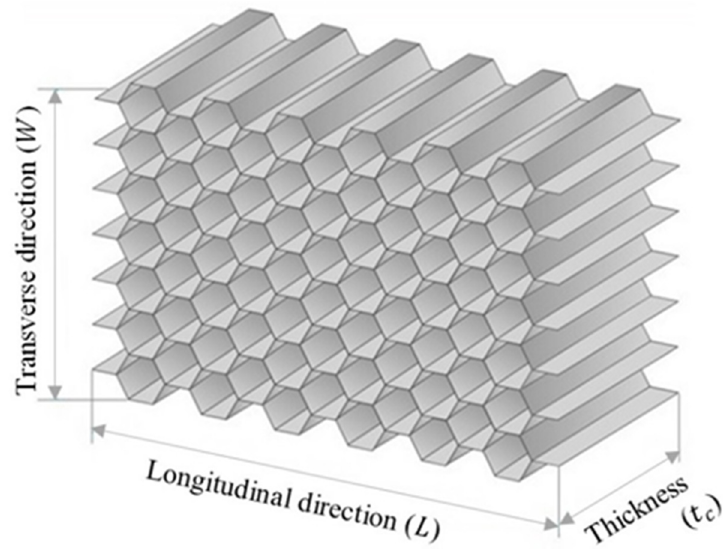
Figure 4. Honeycomb cell configurations (hexagonal core).